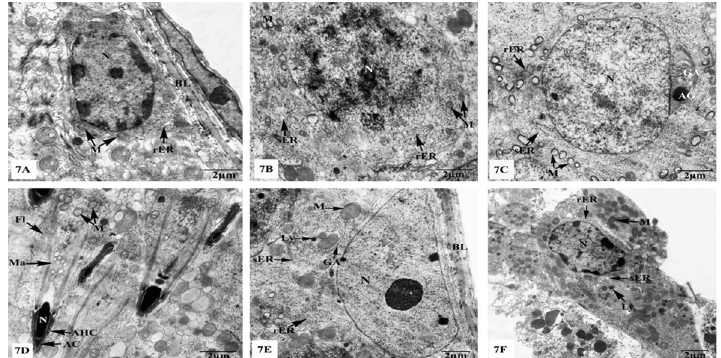
Figure 7. Electron micrographs of the testes of melatonin (MLT)-treated rats showing ( A ) intact spermatogonium resting on basal lamina (BL) having oval nucleus (N), mitochondria (M), and rough endoplasmic reticulum (rER); ( B ) primary spermatocyte with N and cytoplasmic organelles including M, rER, and smooth endoplasmic reticulum (sER); ( C ) fully-developed rounded spermatid with N, acrosomal granule (AG), Golgi apparatus (GA), vacuolated M, sER, and rER; ( D ) elongated spermatids displaying elongated N, acrosomal caps (AC), acrosomal head caps (AHC), manchettes (Ma), and fl agella (Fl), with M. ( E ) Sertoli cell resting upon a thin basal lamina (BL) and has well developed M, sER, rER, GA, and N; ( F ) intact Leydig cell with N, rER, sER, M, and lysosomes (Ly). Scale bar 2 m m.